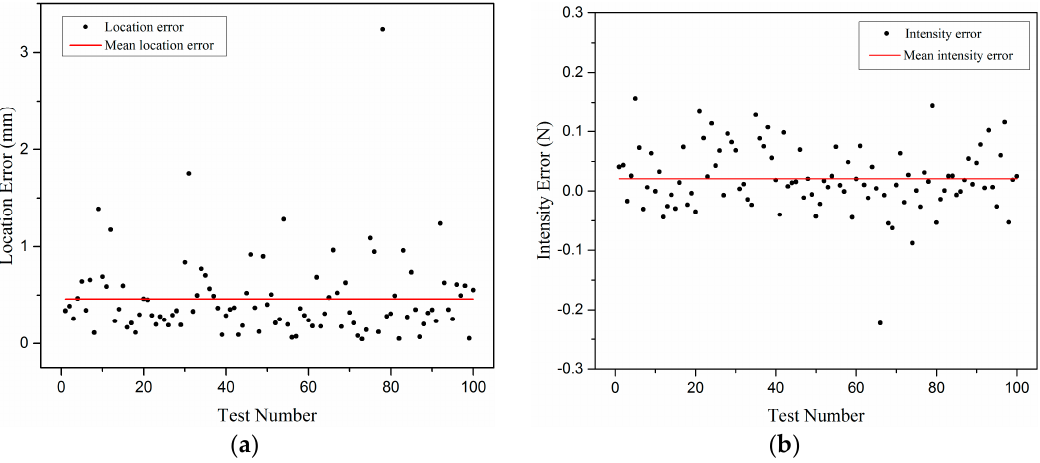
Figure 10. The test results of the inverse algorithm: ( a ) location error distribution; and ( b ) intensity error distribution.